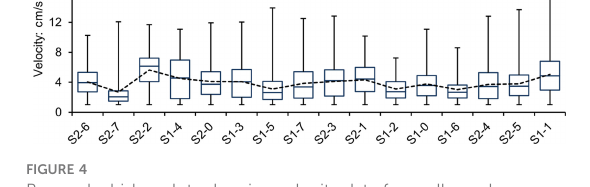
FIGURE 4 Box and whisker plots showing velocity data for scallop valve movements. Box plots show the median, 25 th (lower quartile) and 75 th (upper quartile) percentile (box), and minimum-maximum percentile range (whiskers). The dotted line represents the average velocities for each scallop. The order of samples on the x -axis is based on scallop survival times in this study.